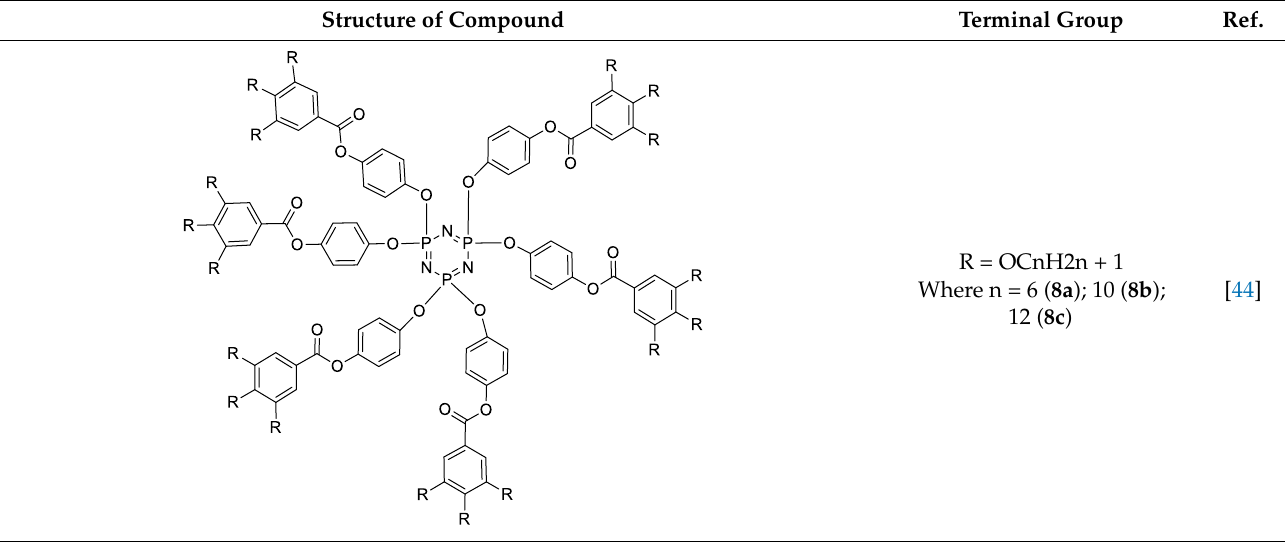
Table 5. Cyclotriphosphaze compounds bearing different terminal side arms. Structure of